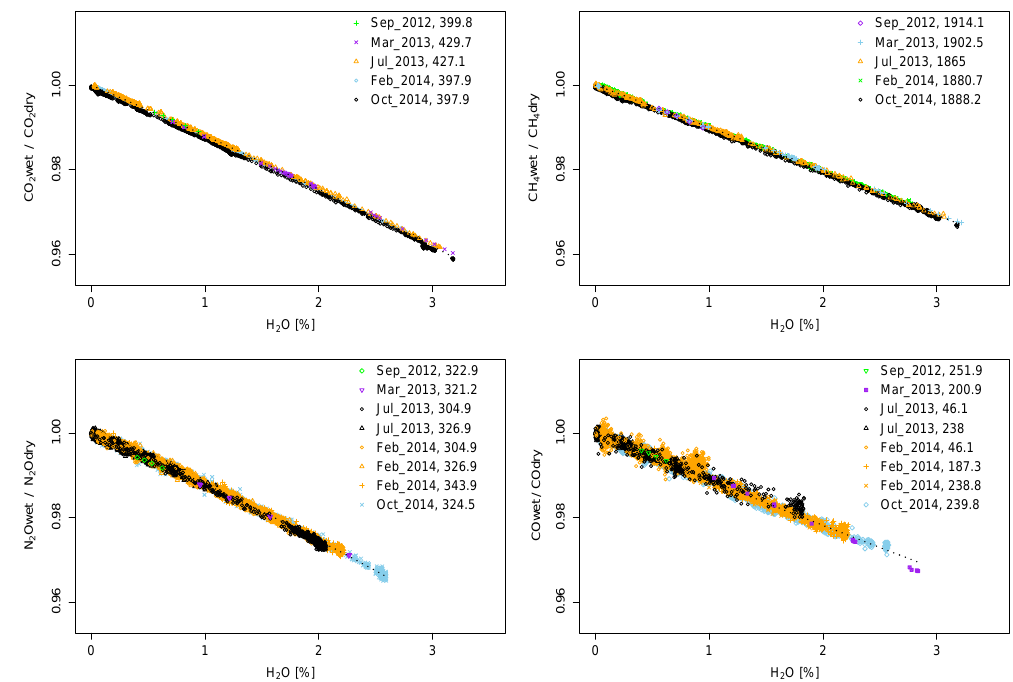
Figure 5. Water correction functions from different tests for all measurands. Colors represent different dates, and shapes represent specific mole fractions of the cylinder used for the test, all in ppb except for CO 2 , which is in ppm.